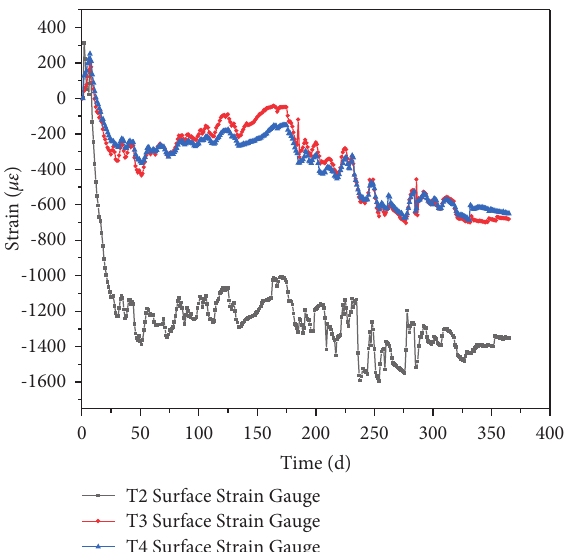
Figure 15: Surface shrinkage strain curves of T2, T3, and T4 specimens with time.